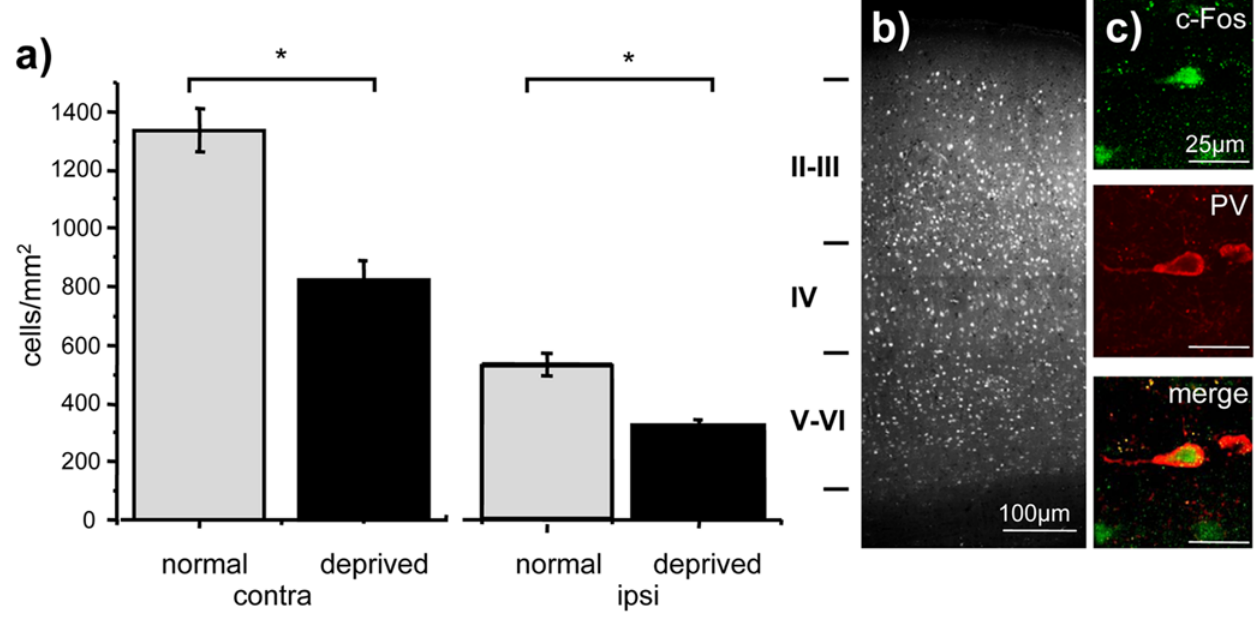
Figure 1. Visual activation of c-Fos. a) c-Fos activation by light is decreased in the binocular primary visual cortex of deprived animals both in the cortex contralateral ( t test, P , 0.001, N=11) and ipsilateral ( t test, P , 0.001, N=11) to the deprived eye; b) example of c-Fos staining after visual stimulation; c) high-magnification images showing the typical co-localization between c-Fos and PV.